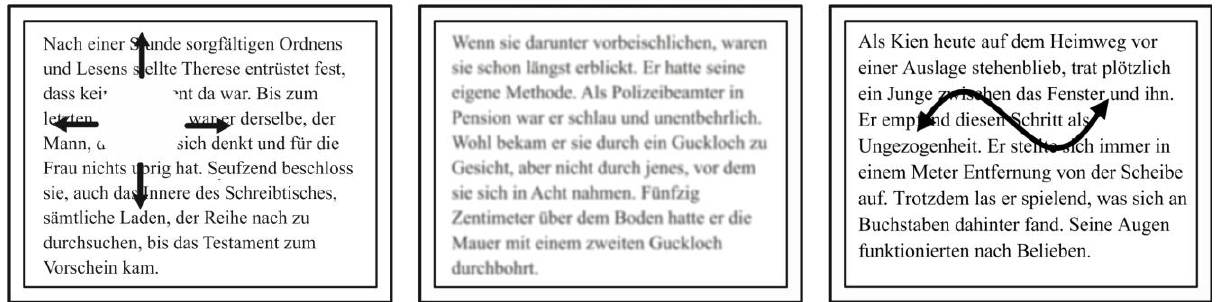
Left panel, shows simulated central scotoma, middle panel shows simulated blurred vision and right panel illustrates simulated oscillopsia. To ensure all types of simulated low vision lead to the same reduced visual acuity in all subjects, a calibration was performed with adjustments of the scotoma size, the blur radius and the frequency of the oscillopsia